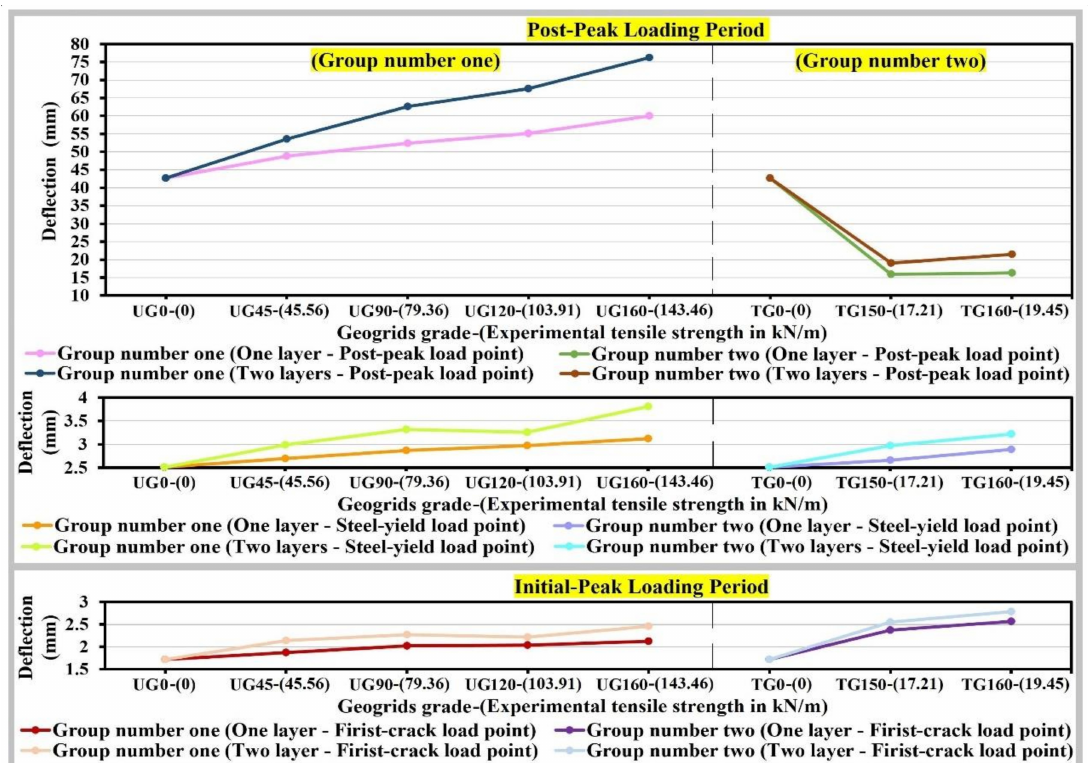
Figure 10. The e ff ect of geogrids type, the tensile strength of geogrids, and the number of geogrids’ layers on concrete slabs’